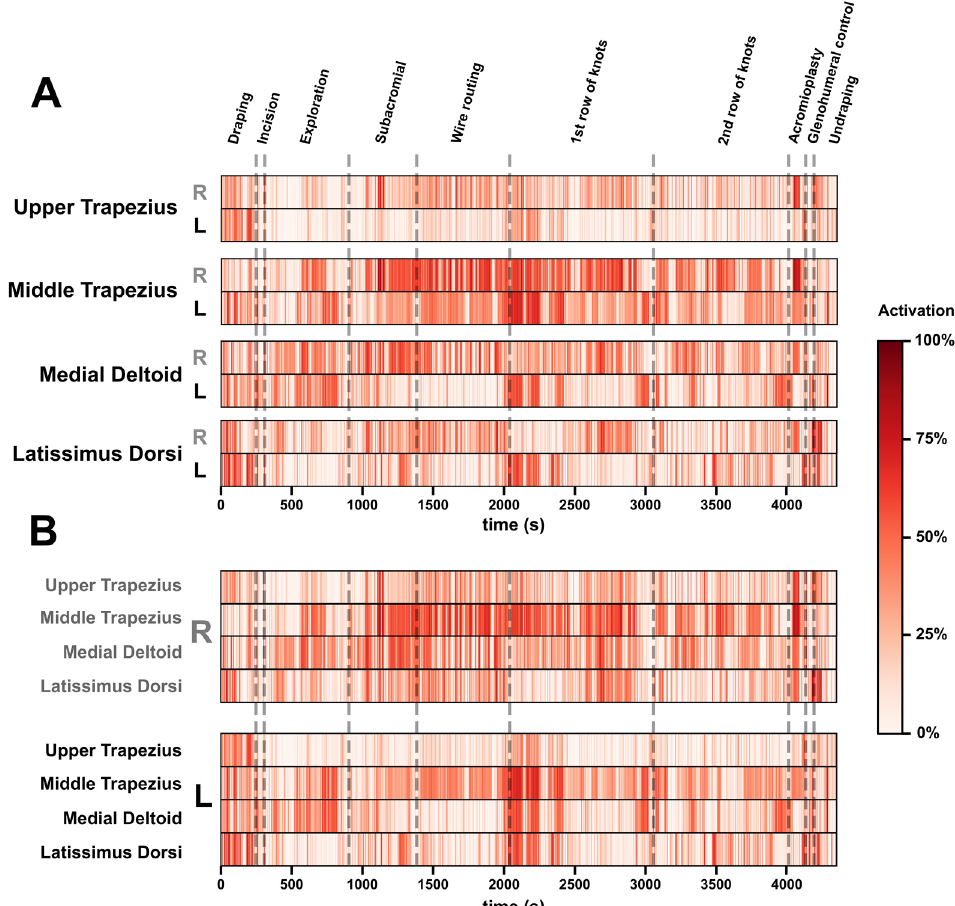
Figure 3. Color-coded muscle activation recorded during the surgical procedure. Time increases from left to right. ( A ) Activation signals grouped by muscle (right and left adjacent for each muscle group) from the anterior to the posterior, for easier functional interpretation. ( B ) Activation signals but grouped by laterality (all right muscles in grey, all left muscles in black) for easier asymmetry detection. Colours range from white (0%) to dark red (100%). The different surgery stages are marked as vertical dashed lines.